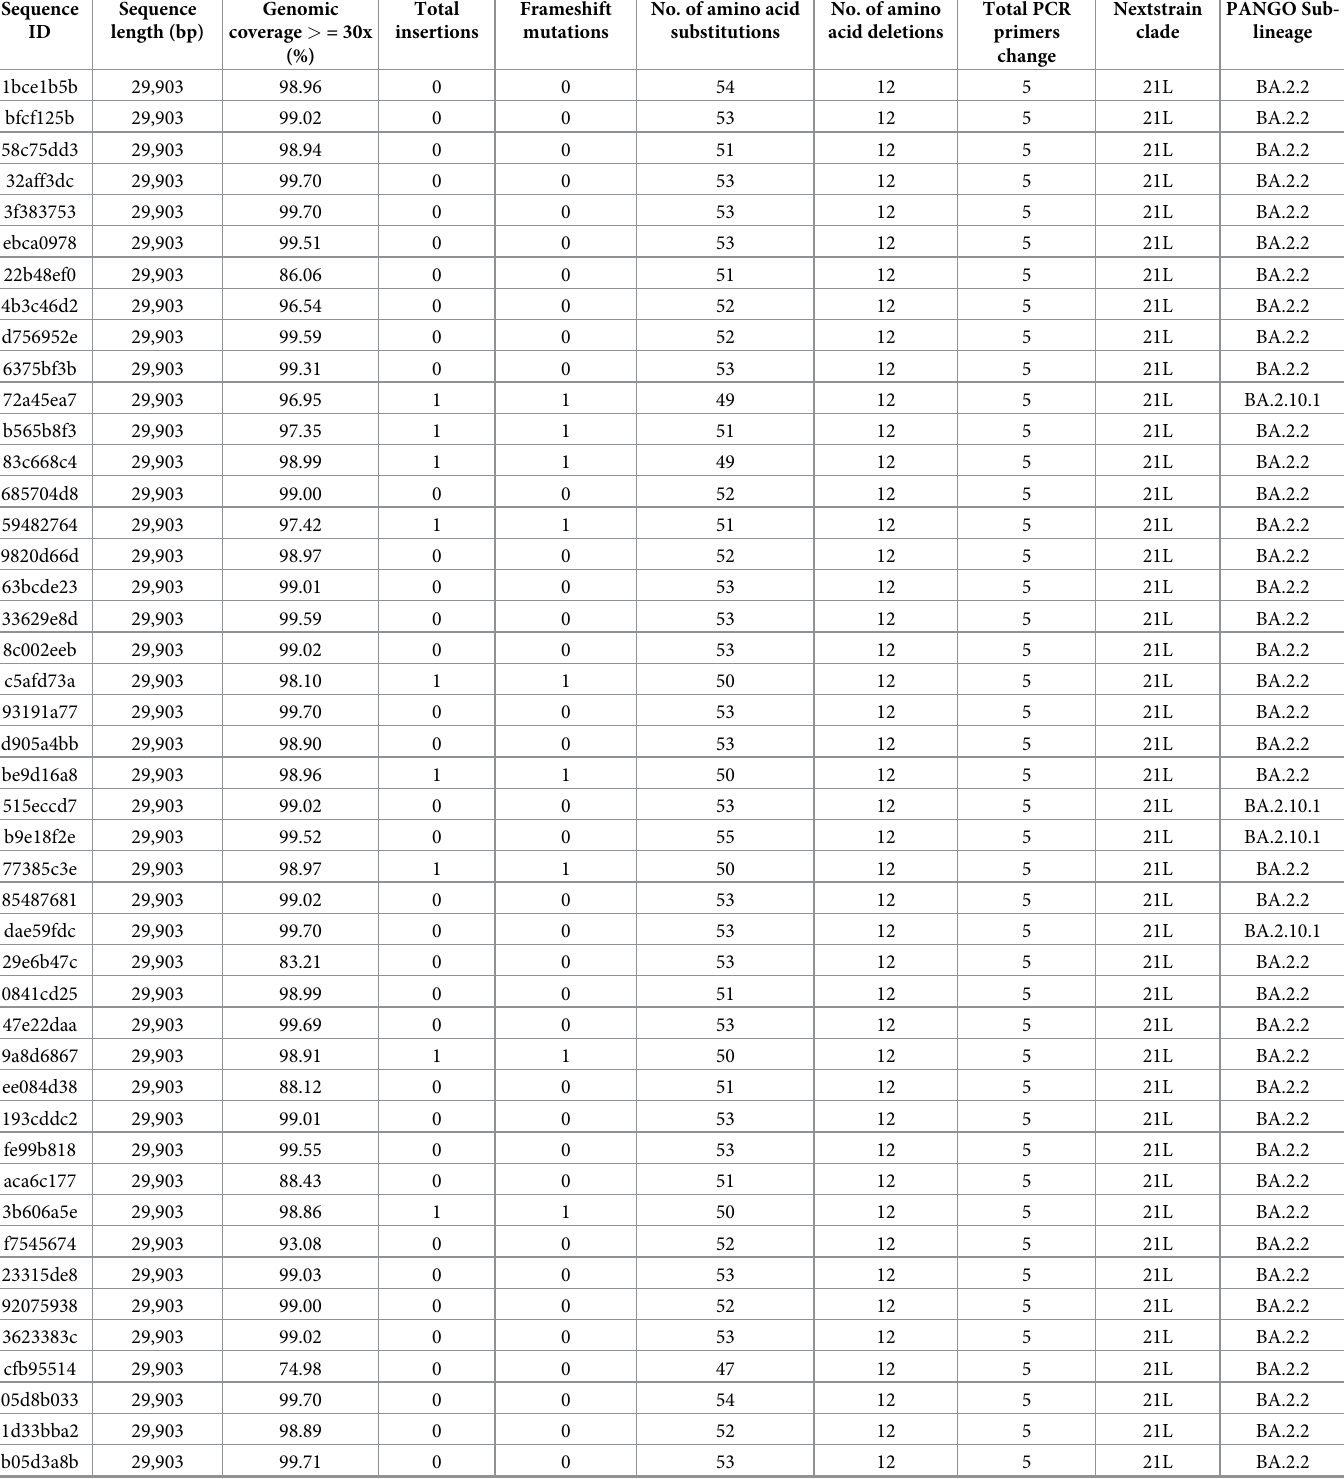
Table 2. Whole viral genome sequencing statistic and features of B.1.1.529 Omicron variant. All genome sequences analyzed in this study were submitted to GISAID under accession numbers EPI_ISI_13822514 to 13822565 and EPI_ISI_14336314 to